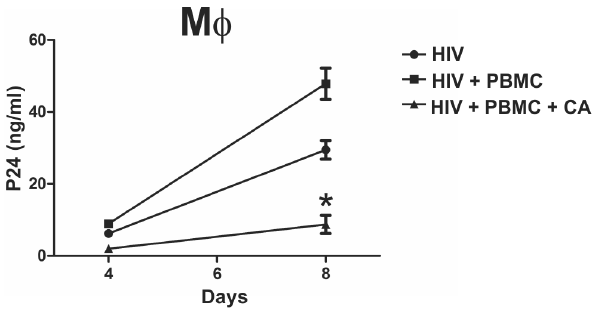
Figure 2. Candida albicans inhibits transmission of HIV-1 from macrophages to activated peripheral blood mononuclear cells. Macrophages (5x10 5 /0.5 ml) were incubated with the R5 tropic virus HIV-1 (50 ng p24/ml) for BaL